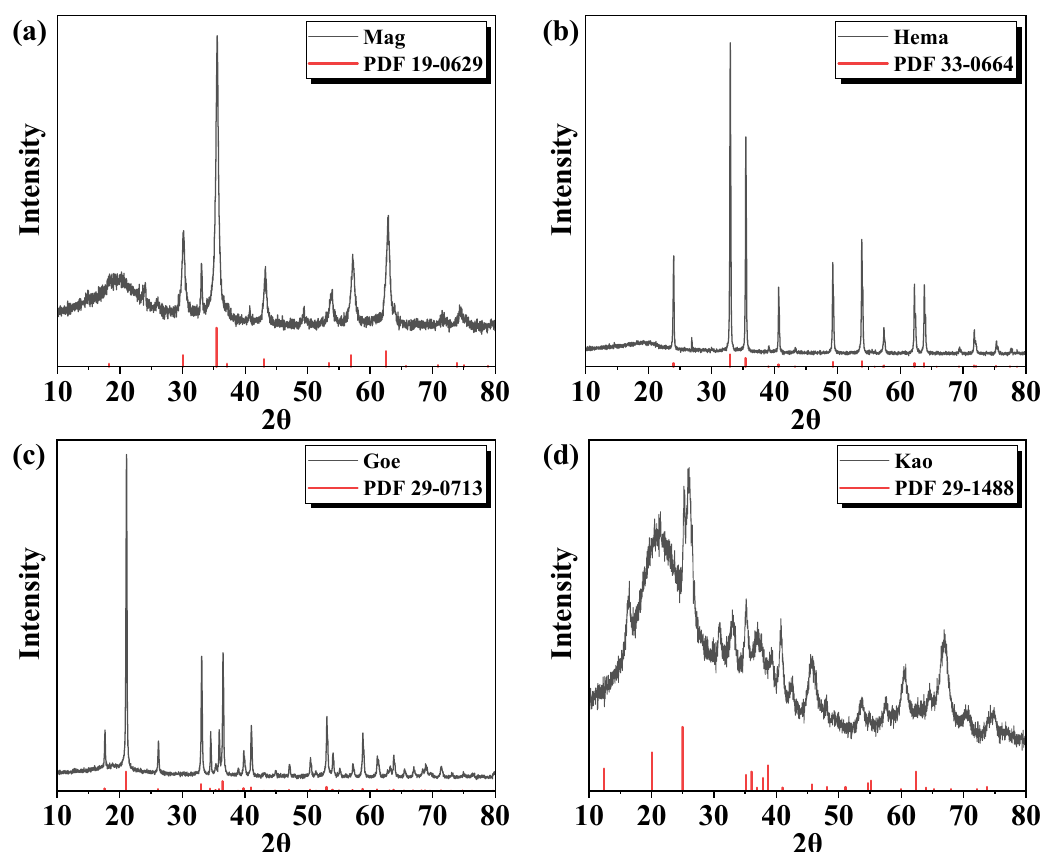
Figure 1. XRD patterns of ( a ) Mag, ( b ) Hema, ( c ) Goe, and ( d ) Kao.